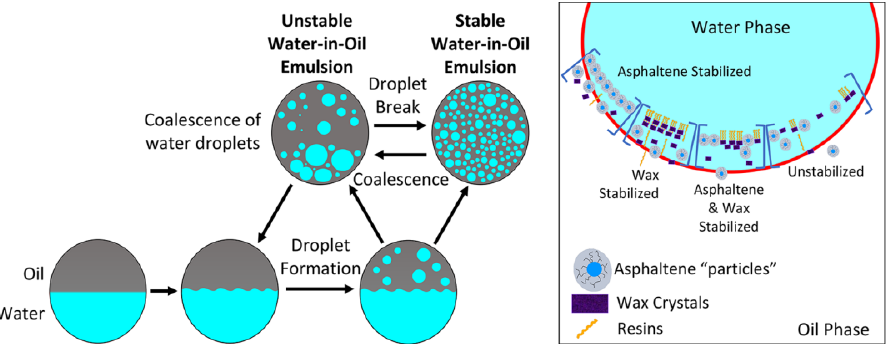
Figure 15. General mechanisms involved in the emulsification and demulsification processes of water-in-oil emulsions in the presence of asphaltenes. Reprinted with permission from Ref. [155]. Copyright 2022, copyright the American Chemical Society. More details on Copyright and Liscensing are available via the following link: https://pubs.acs.org/.